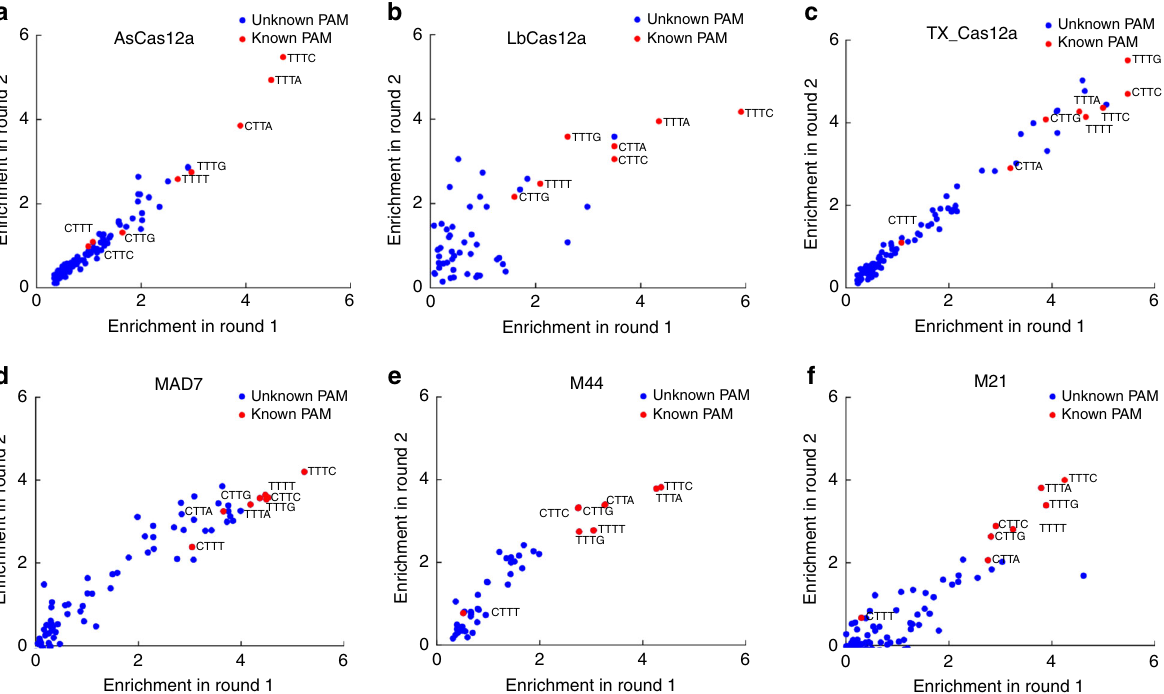
Fig. 4 The speci fi city detection of chimeric Cas12a-type variants. a – f The enrichment score for two rounds of PAM scans. The enrichment score is the frequency change (log 2 ) of each PAM using different gRNA plasmids (on-targeting and non-targeting gRNAs) (online method). a AsCas12a, b LbCas12a, c TX_Cas12a, d MAD7, e M44, and f M21.